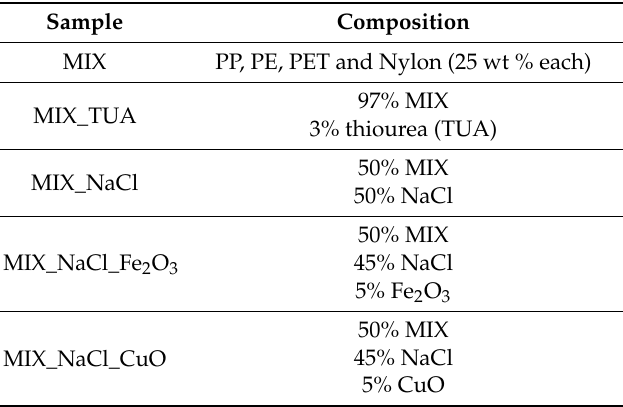
Table 1. Composition of the samples studied (wt %).